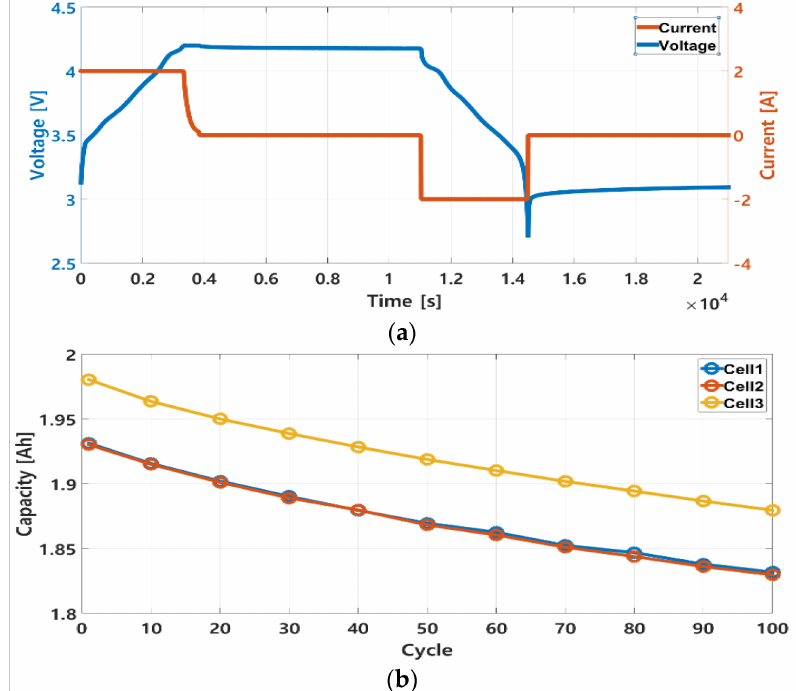
Figure 6. Aging cycle test of the NCA cell considering a 1C-rate (100 times) and its experimental result (capacity degradation): ( a ) basic discharging / charging current profile for aging (CC-CV), and ( b ) capacity degradation considering a 1C-rate (100 times).